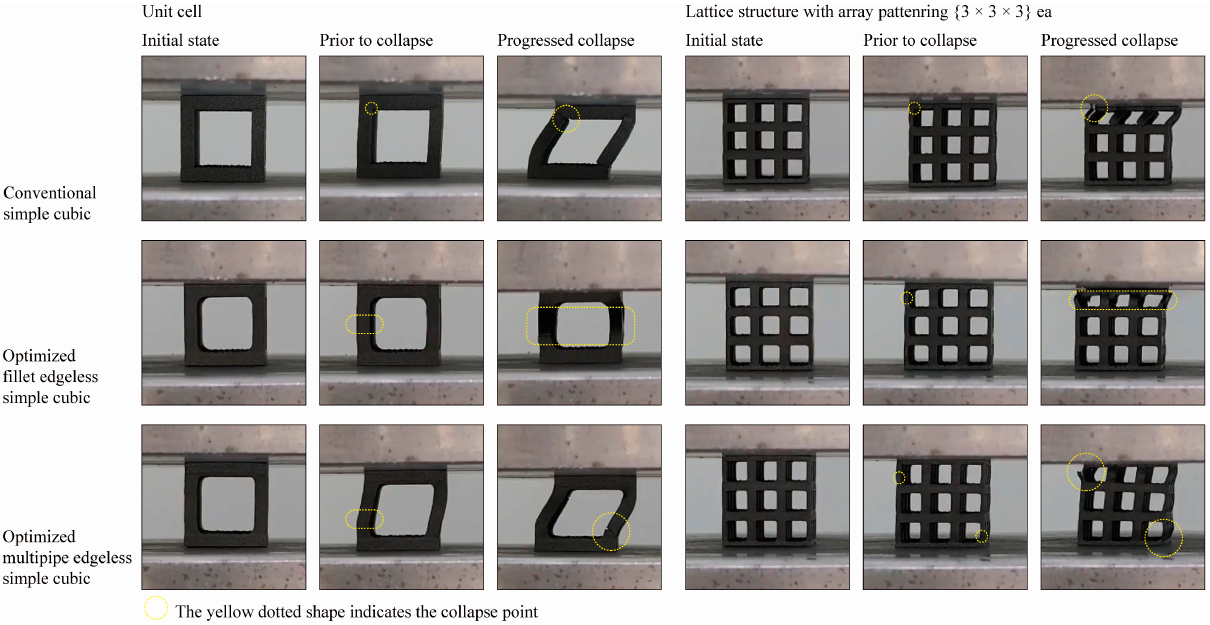
Figure 19. Compressive deformation response of optimized edgeless simple cubic la tt ice structures. Table 5 and Figure 20 present the results of experimental compressive strength tests.